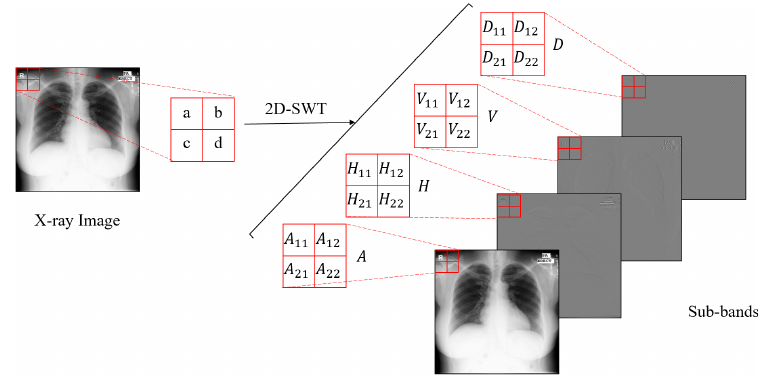
Figure 2. 2D-SWT of a X-ray image using